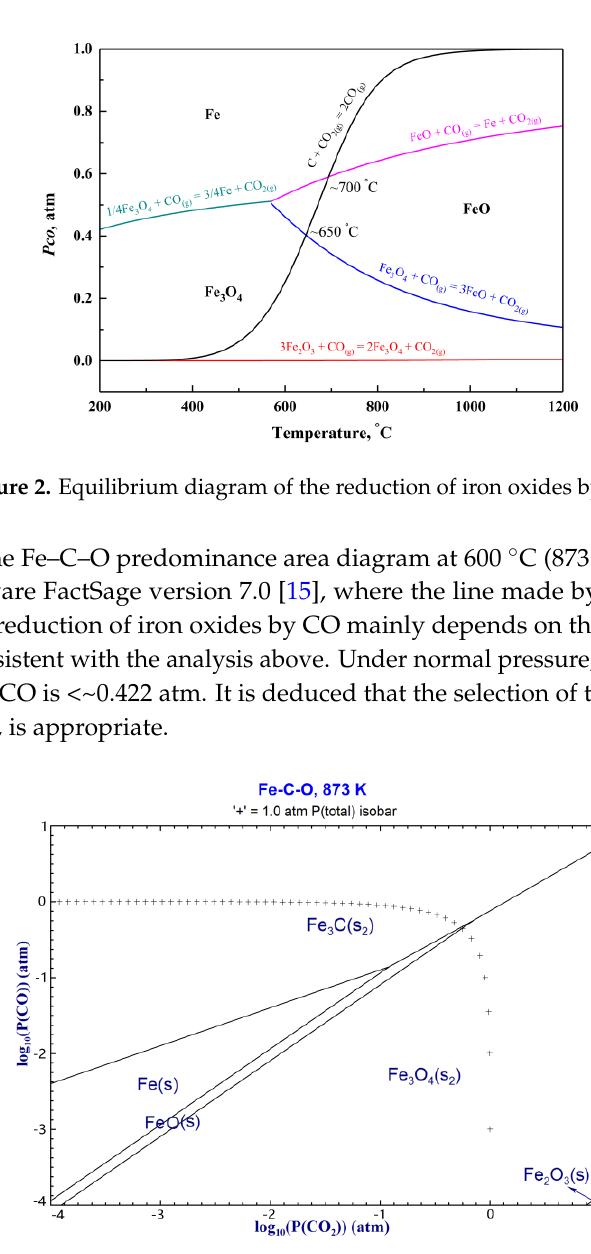
Figure 1. Relationship between temperature and Gibbs free energy of formation of oxides.